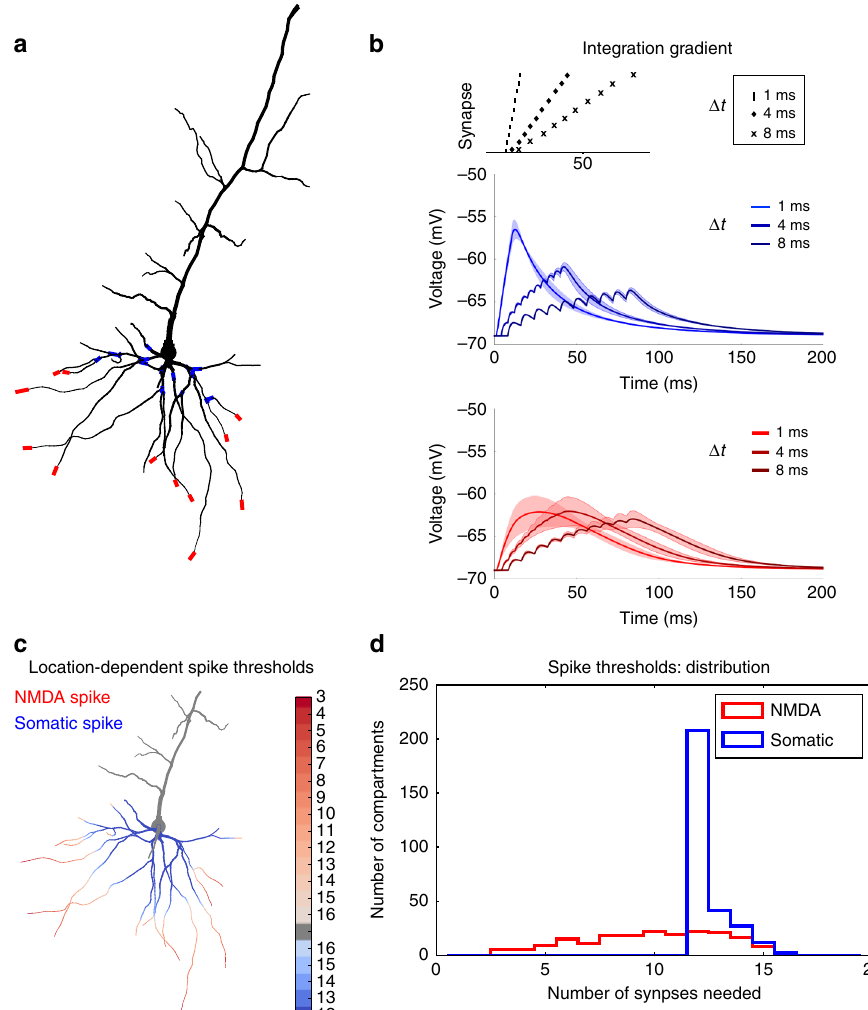
Fig. 1 Location dependence of local and global regenerative events. a Proximal ( blue ) and distal ( red ) locations on a thin basal branch of the detailed neuron model. b Temporal integration gradient along a basal dendrite (reproducing experimental results by Branco and Häusser 47 ). Top panel : activation sequences with different interspike intervals. Middle panel: proximal stimulation requires high temporal coincidence, as the somatic depolarisation drops substantially when inputs are not active synchronously. The solid line is the mean over all proximal compartments shown in panel a , the shaded region is one s.d. Bottom panel : distal stimulation results in similar somatic depolarisation over a bigger range of interspike intervals. The solid line is the mean over all distal compartments shown in panel a , the shaded region is one s.d. c For each dendritic compartment in the neuron model, synapses are activated until either an NMDA spike or an action potential is generated. Stimulating proximal compartments results in an action potential before reaching the threshold for NMDA spikes ( blue ). Stimulating distal regions results in NMDA spike generation while staying sub-threshold for somatic spikes ( red ). Intenser colours denote that less synapses are needed to evoke a spike. The numbers next to the colour bar represent the number of synapses needed for a spike. d For each compartment in c , the number of synapses needed to evoke the spikes was stored and represented as a histogram. NMDA spikes ( red ) generally require less synapses in our model than somatic spikes ( blue